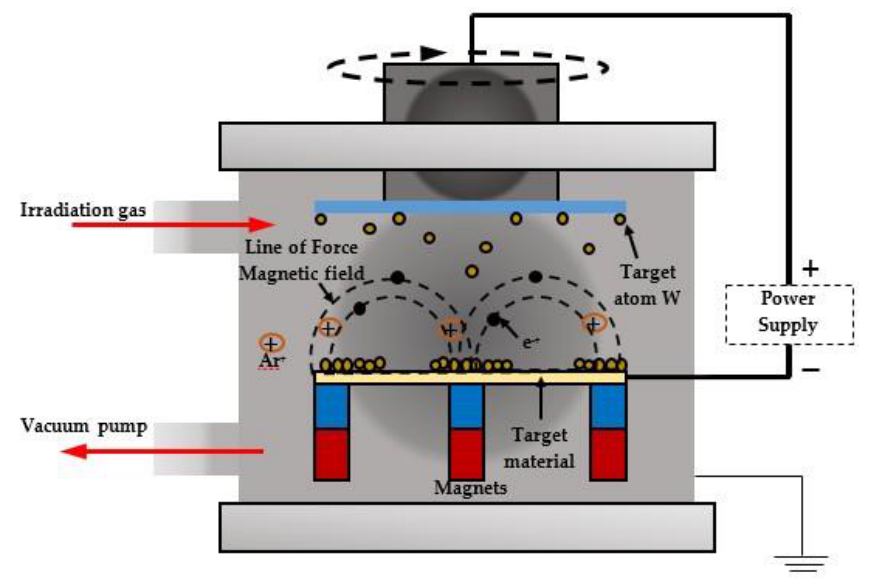
Figure 30. Magnetron sputtering apparatus (working principal).